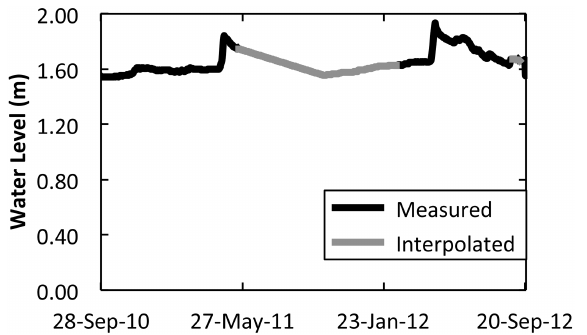
Figure B1. The water level in Goldstream Lake, as calculated from measurements of hydrostatic pressure on the lake bottom or as interpolated from precipitation measurements when pressure measurements were unavailable.